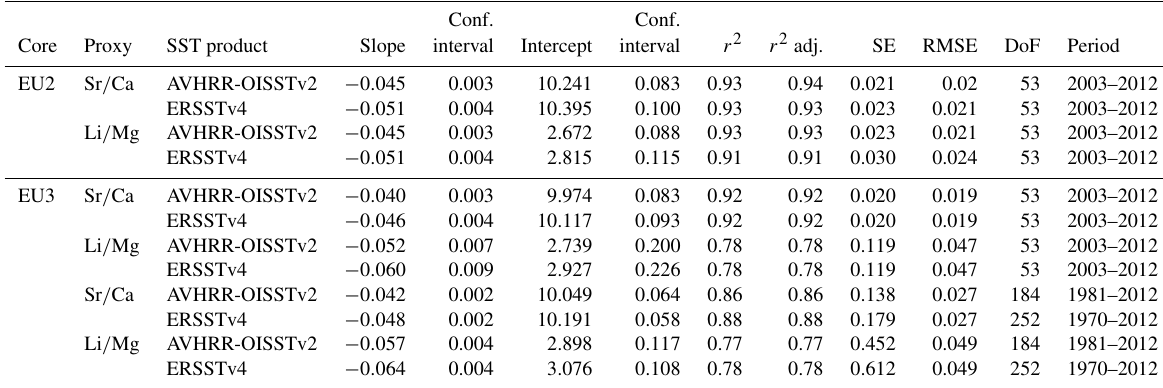
Figure 4. Scatterplot of bimonthly trace element ratios in cores EU2 (black dots) and EU3 (blue dots) over the full length of the records. (a–c) Sr / Ca ratios vs. Li / Mg, Mg / Ca, and Li / Ca, (d–e) Li / Mg vs. Mg / Ca and Li / Ca, and (f) Li / Ca vs. Mg / Ca. The 95% prediction intervals of the regressions are indicated by red dashed (EU3) and green solid lines (EU2) with linear fits for each core indicated by a red line. Regression equations are provided in Table S1. Table 2. Robust linear regression equations (weighted least squares) for core EU2 and EU3 Sr / Ca and Li / Mg ratios with AVHRR-OISSTv2 and ERSSTv4. Conf.